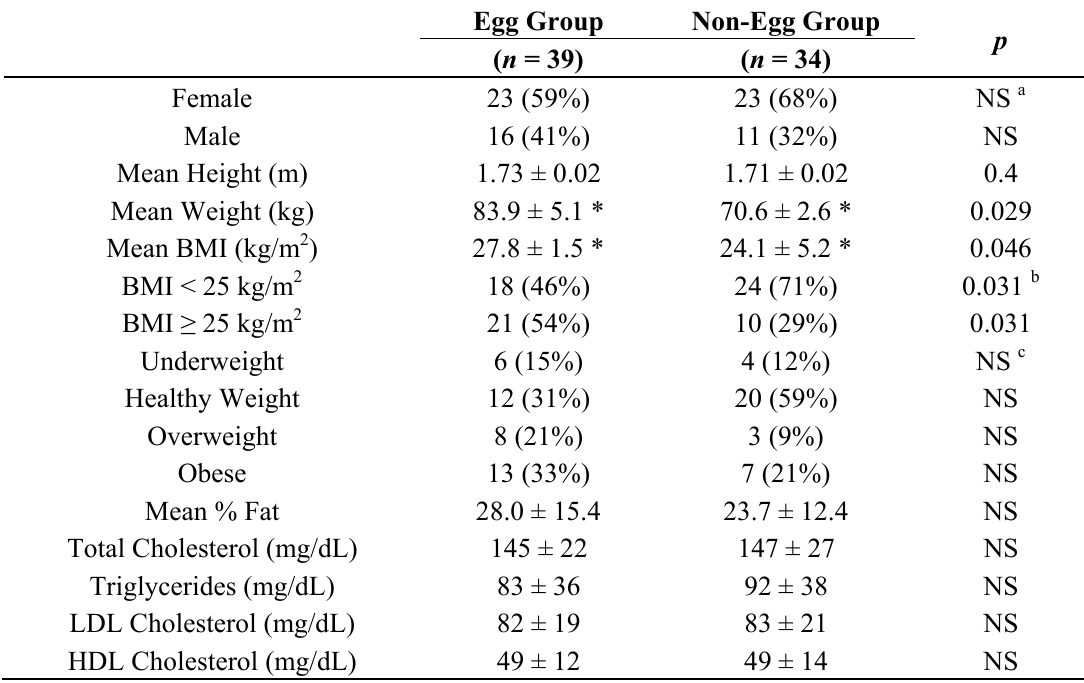
Table 1. Baseline characteristics of